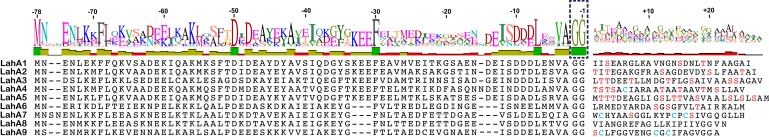
(A) Precursor peptides encoded in Lachnospiraceae C6A11 highlighting the conservation in the leader peptide with a sequence conservation logo (Crooks et al., 2004).The double Gly motif is boxed.